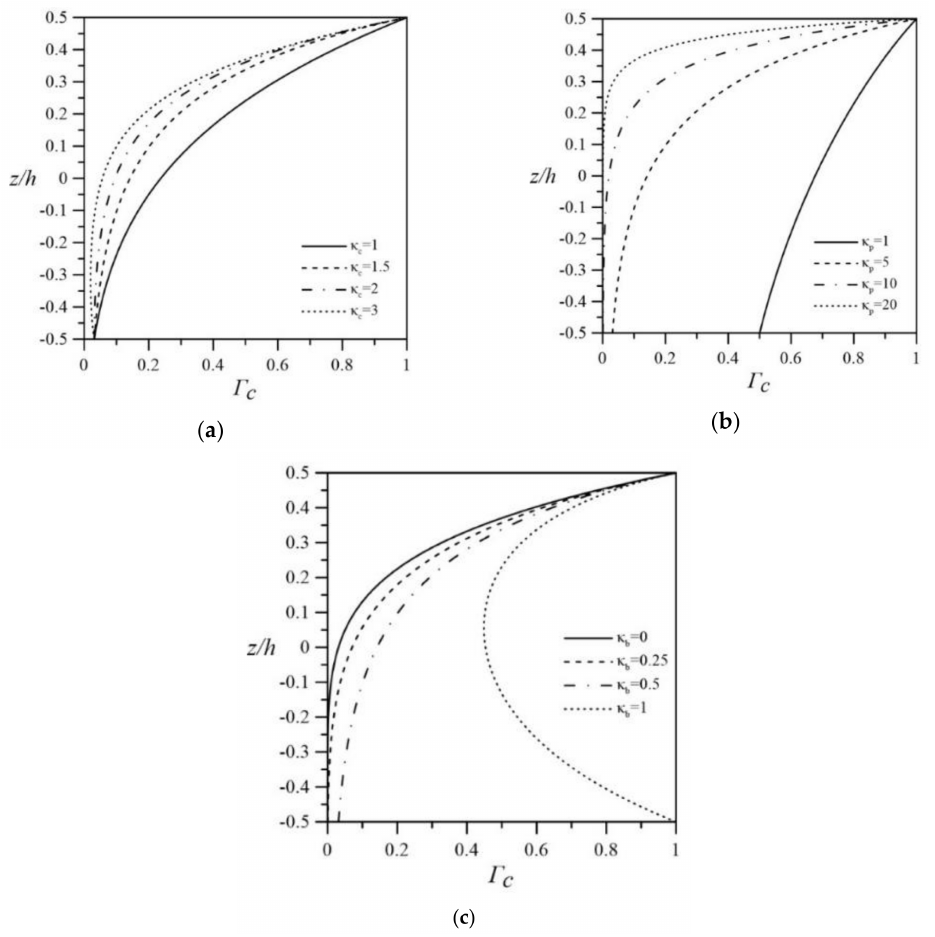
Figure 2. Through-thickness distributions of the volume fractions of the ceramic material for a three-parameter power-law material model when ( a ) κ b = 0.5, κ p = 5, and κ c = 1, 1.5, 2, and3; ( b ) κ b = 0.5, κ c = 1.5,and κ p = 1, 5, 10, and20; and ( c ) κ p = 5, κ c = 1.5, and κ b = 0, 0.025, 0.5, and1.